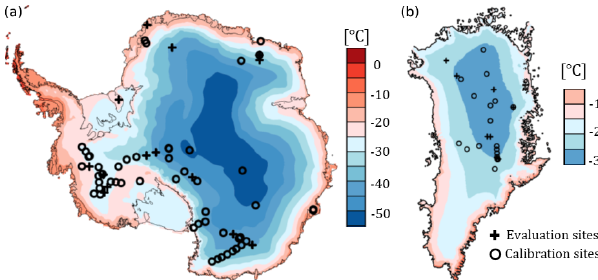
Figure 1. Maps of Antarctic (a) and Greenland (b) ice sheets. Back- ground is mean annual air temperature as modelled by RACMO2. Note the different colour